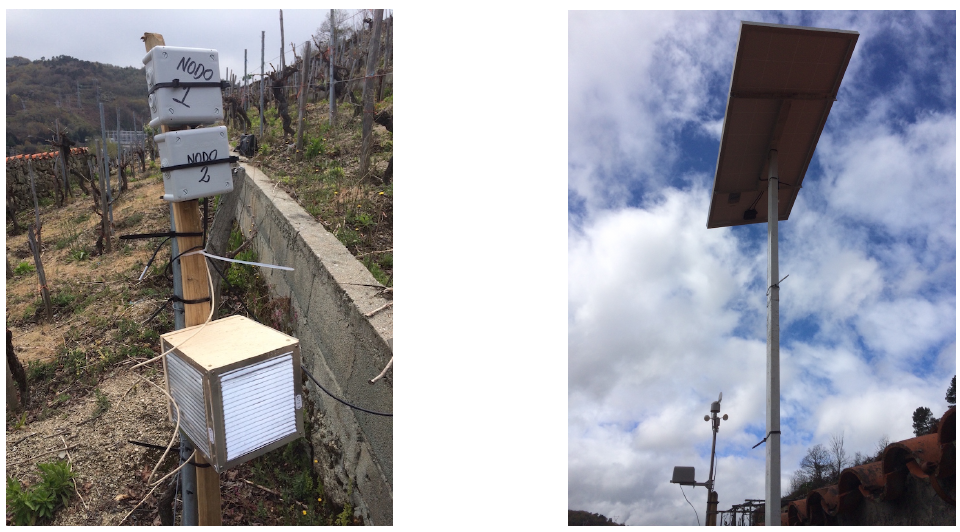
Figure 10. Example of Type-1 and Type-2 nodes deployed on the vineyard ( left ) and galvanized structure for the solar panel ( right